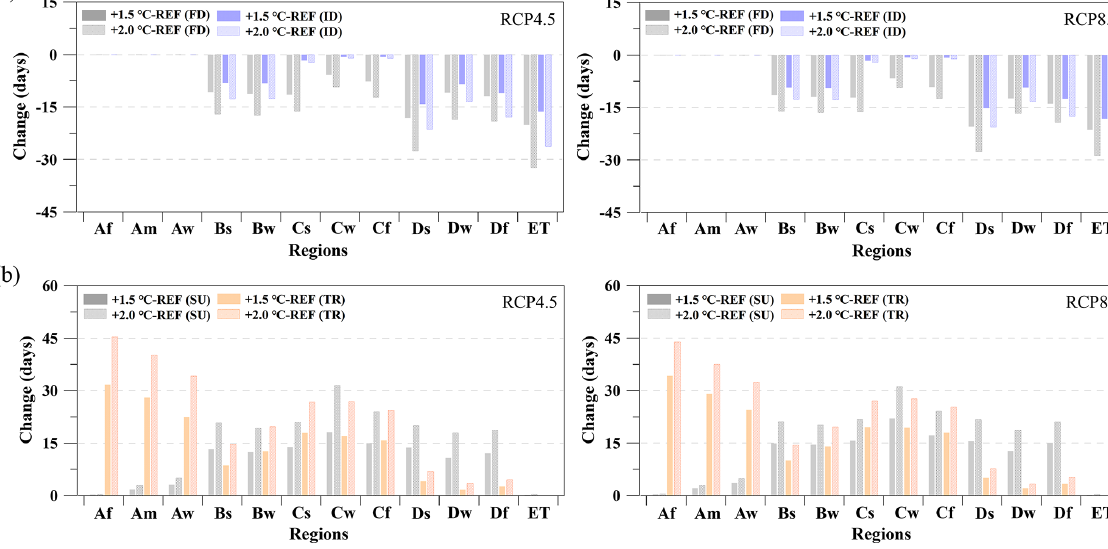
Figure 5. Changes in the extreme temperature indices (a) related to the coldest days (FD: frost days and ID: ice days) and (b) related to the hottest days (SU: summer days and TR: tropical nights) derived from the MME for the 12 climate